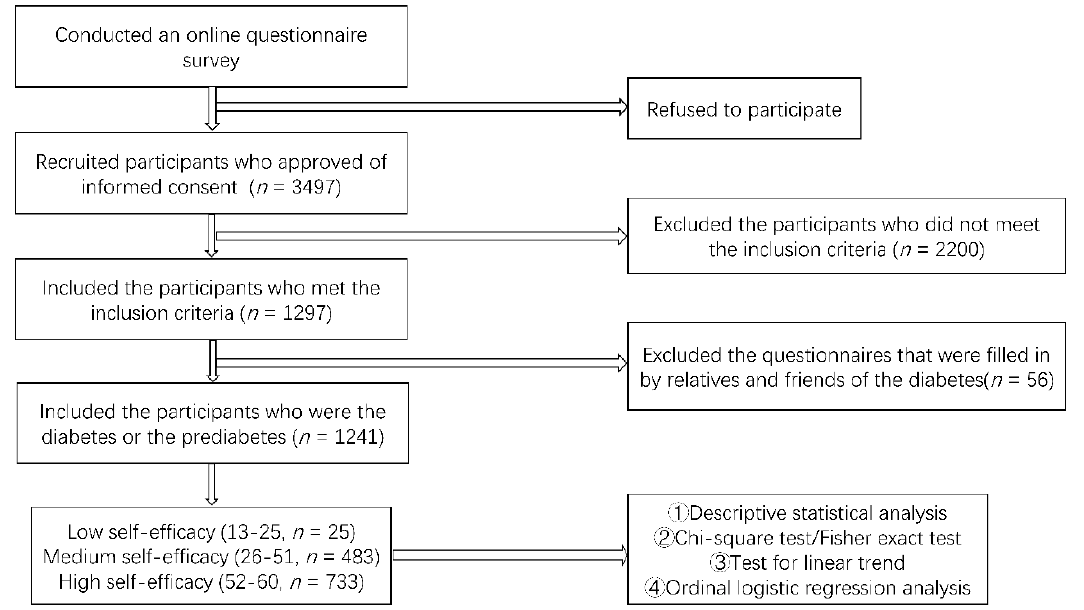
Figure 1. Research flow diagram.